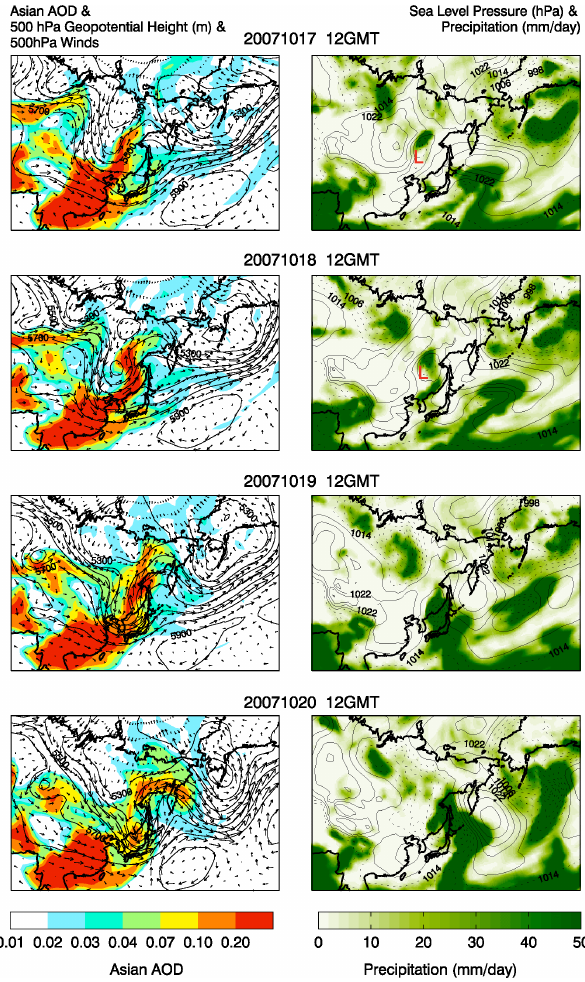
Figure 10. Synoptic situation during the initial stages of the export event of October 20-27. Conventions are the same as Fig. 10. Synoptic situation during the initial stages of the export in Figure 3. event of 20–27 October 2007. Conventions are the same as in Fig.